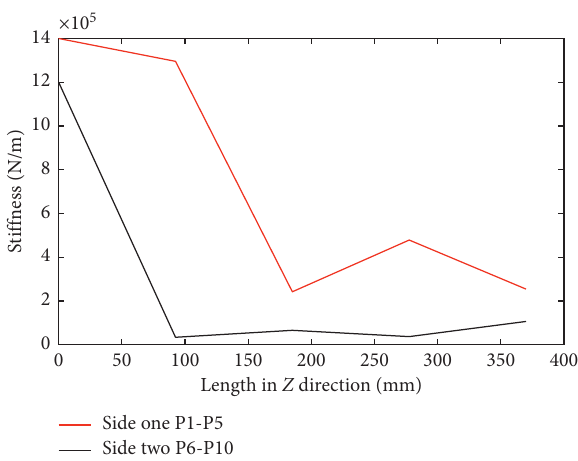
Figure 7: Computed stiffness of the hollow